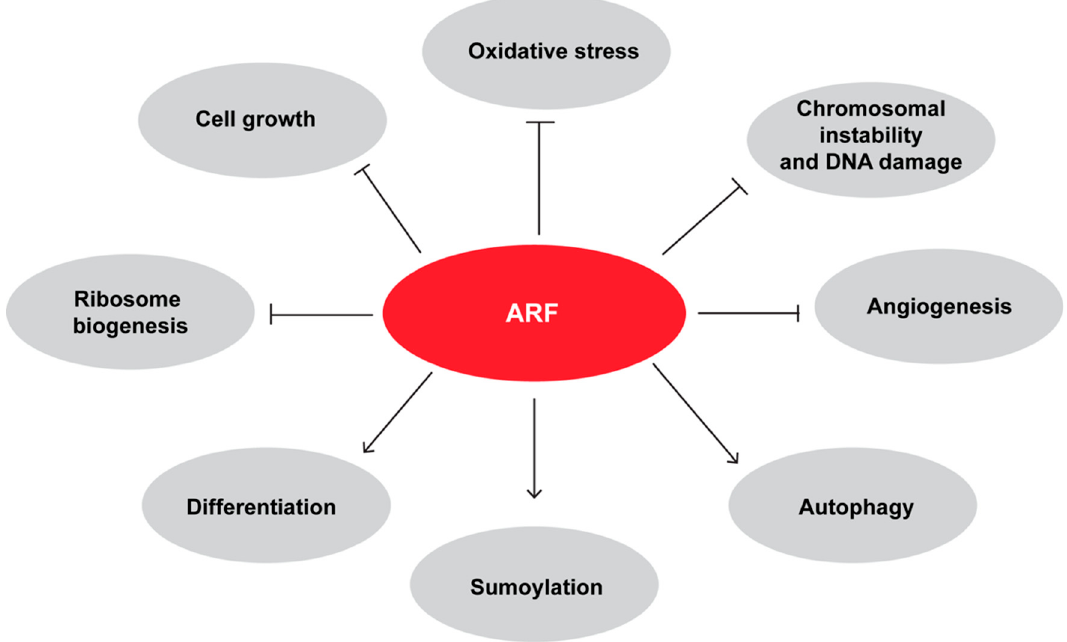
Figure 3. Synopsis of the effect of ARF in cellular processes. Note that the ARF negative effect on cell growth includes its ability to block cell proliferation and to induce apoptosis or senescence.